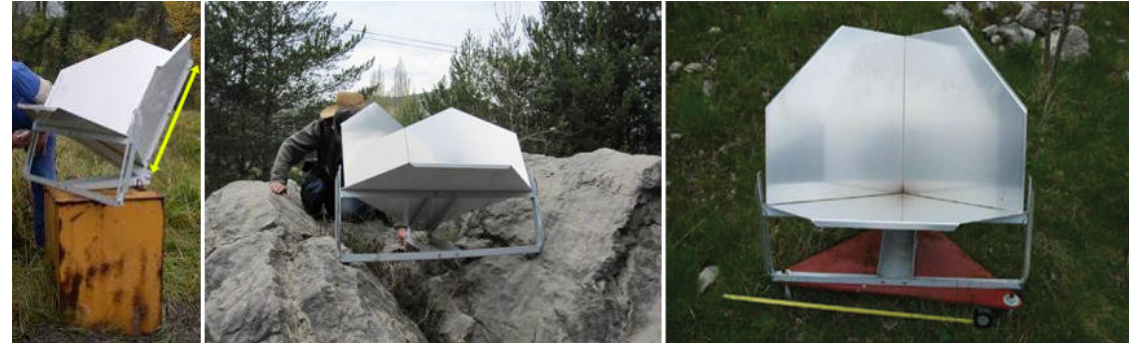
Fig. 2. Corner Reflectors (CRs) used to monitor the Vallcebre landslide. The yellow arrow indicates the size of the side of the CRs which is 67cm. Three types of CR installation were performed in the Vallcebre landslide: over a metallic box, on rocks or directly over the terrain.